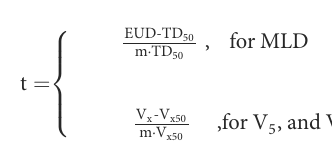
for the VMAT FFF and VMAT FF plans for all 198 lung SBRT plans (generated on 175 patients with 198 independent isocentre) is presented in Table 4. In general, the dose within the PTV was similar for the VMAT FFF plan and the VMAT FF plan. There was no signi fi cant difference in D 90 , CR and the CI of the PTV between the two plans ( p >0.05). However, the D 2 , R 50% and GI of the VMAT FFF plan were signi fi cantly lower than the VMAT FF plan ( p <0.05). D 2 of the PTV was 55.30 ± 0.45 Gy for the VMAT FFF plan and 55.90 ± 0.50